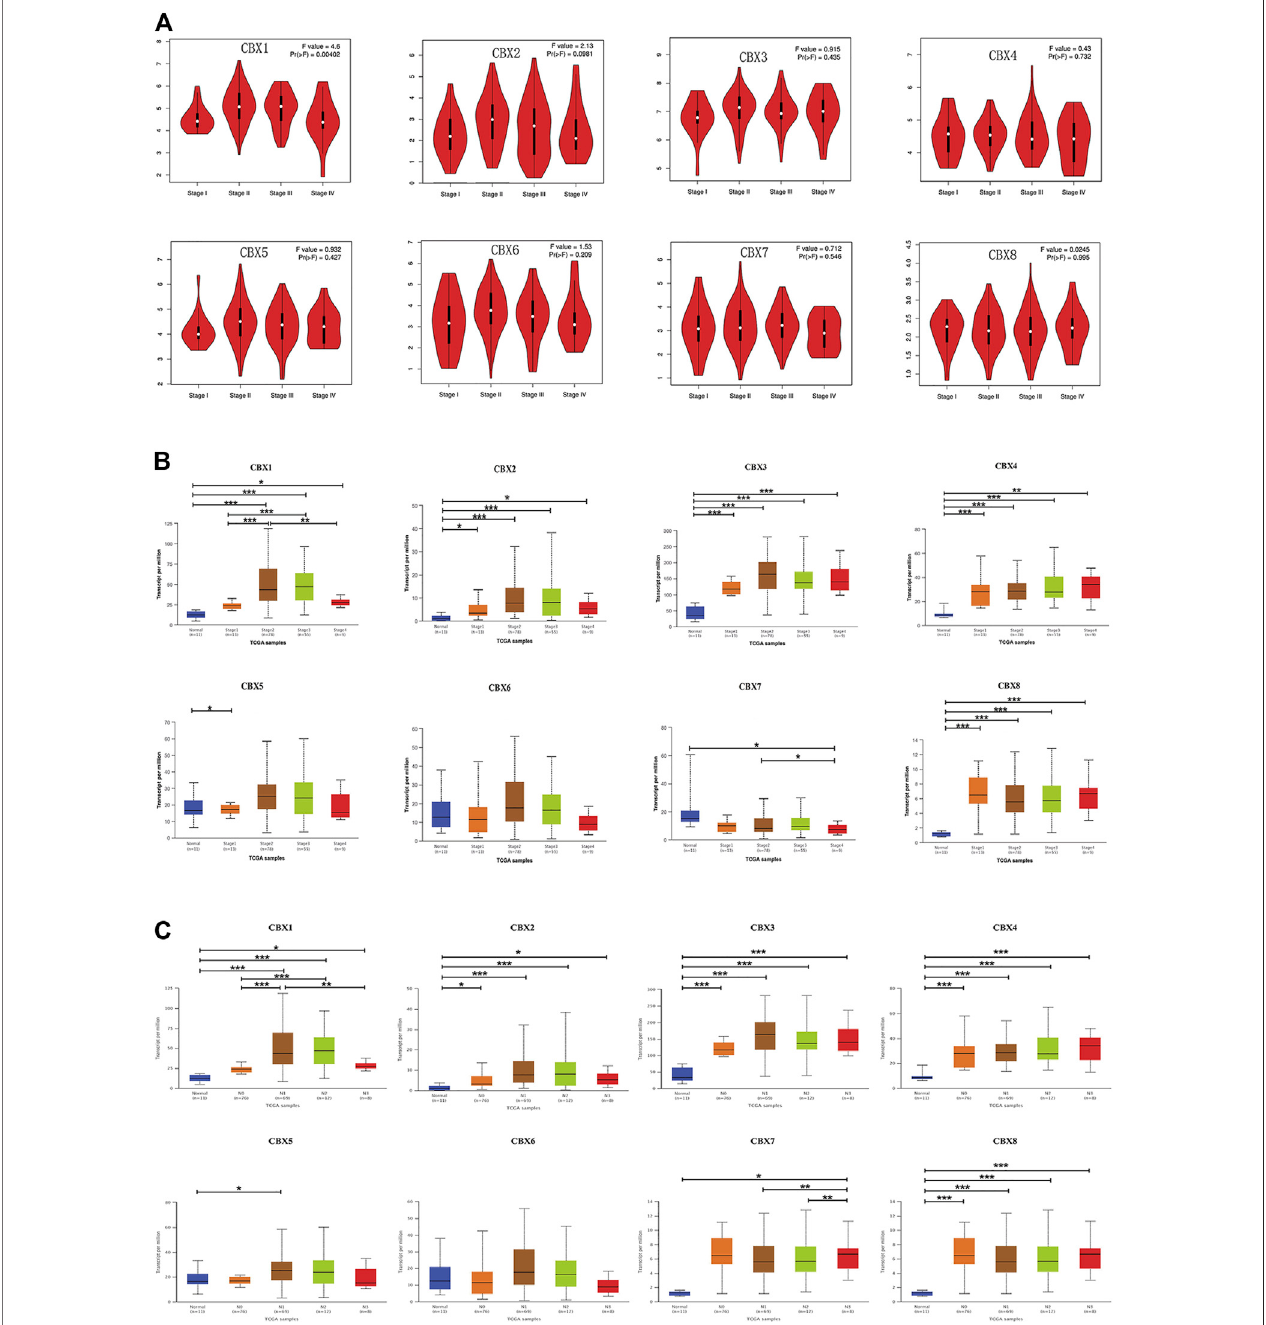
FIGURE 3 | (A) Correlation between different expressed CBXs and the pathological stage of ESCA patients in GEPIA. * p < 0.05. (B) Relationship between mRNA expression of distinct CBX family members and individual cancer stages of ESCA patients. * p < 0.05, ** p < 0.01, *** p < 0.001. (C) Association of mRNA expression of distinct CBXs family members with tumor nodal metastasis status of ESCA patients. * p < 0.05, ** p < 0.01, *** p <